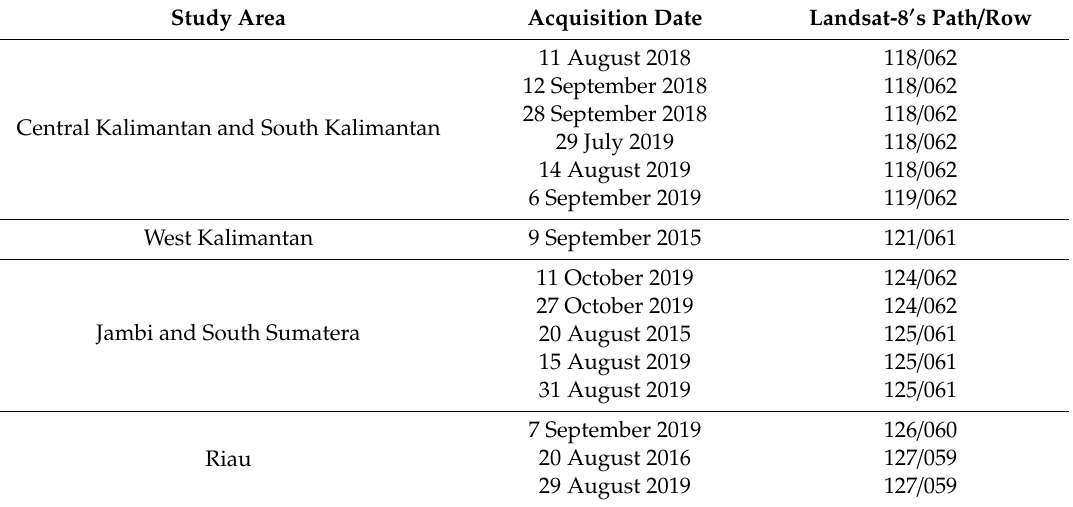
Central Kalimantan and South Kalimantan